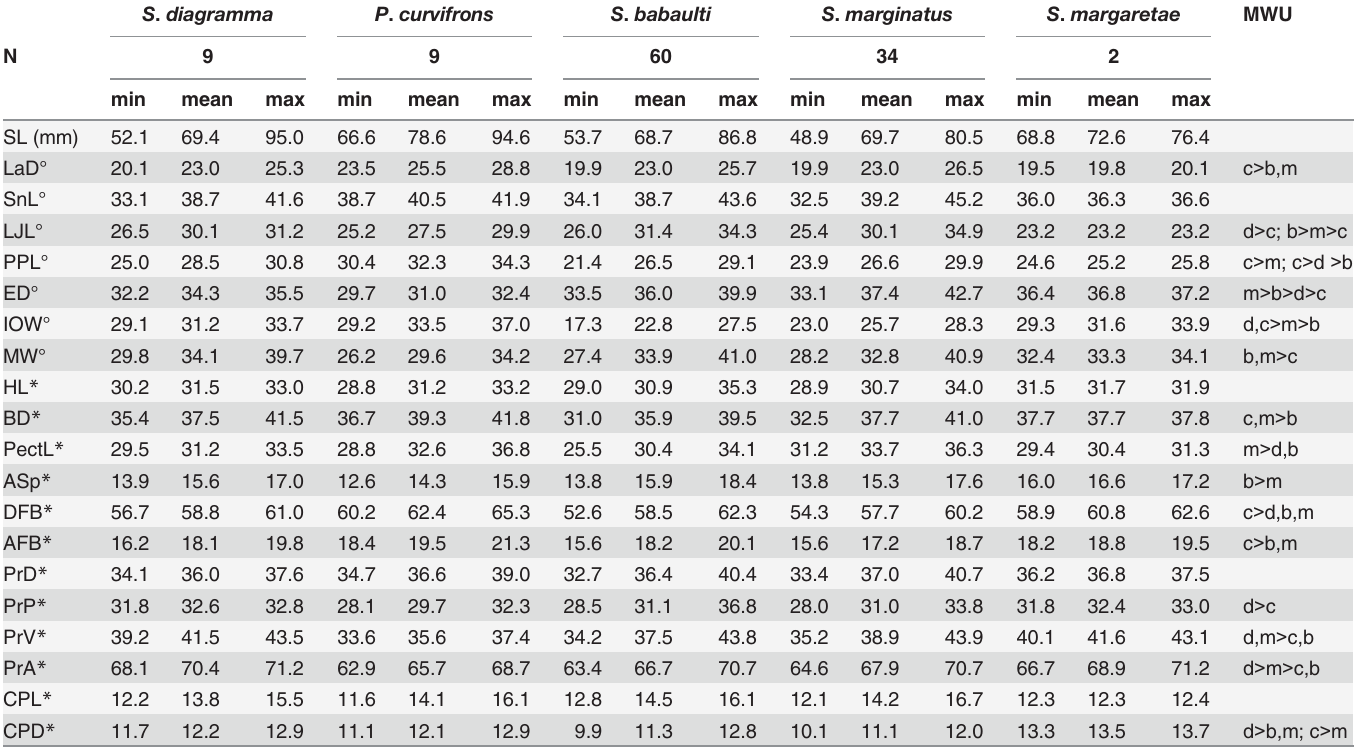
Table 4. Summary of measurements of the different Simochromis and Pseudosimochromis species. S .